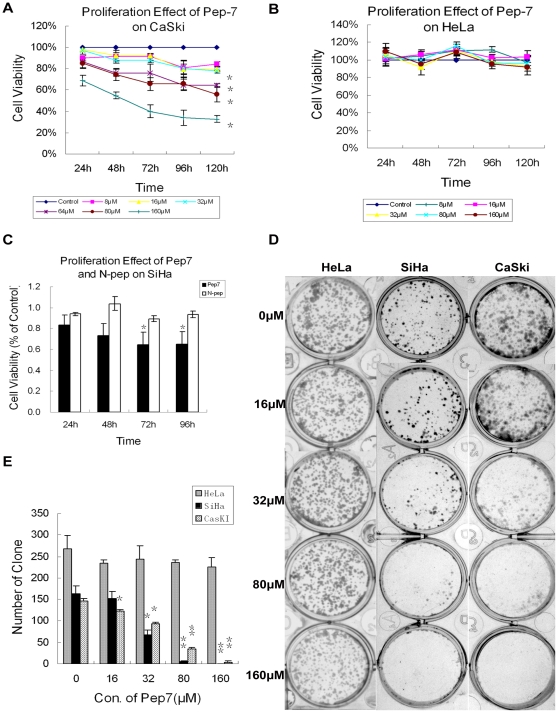
Effect of Pep-7 on Cell Proliferation.The effect of Pep-7 on cell growth at concentrations indicated were tested by MTT and clonogenic assay. Cell viability was presented as a percentage of A540 relative to the control cells. MTT experiments (A to C) results are presented as mean ± SE of data obtained from at least two independent run in sextuplicate. (A) Pep-7 effect on CaSki cell growth; (B) Pep-7 effect on HeLa cell growth; (C) comparing effect of 80 µM N-pep and Pep-7 on SiHa cell growth; (D) Photograph of cell clones stained with crystal violet; and (E) The average ± SE clone numbers of each group from three independent experiments (*, p<0.02; **, p<0.01).